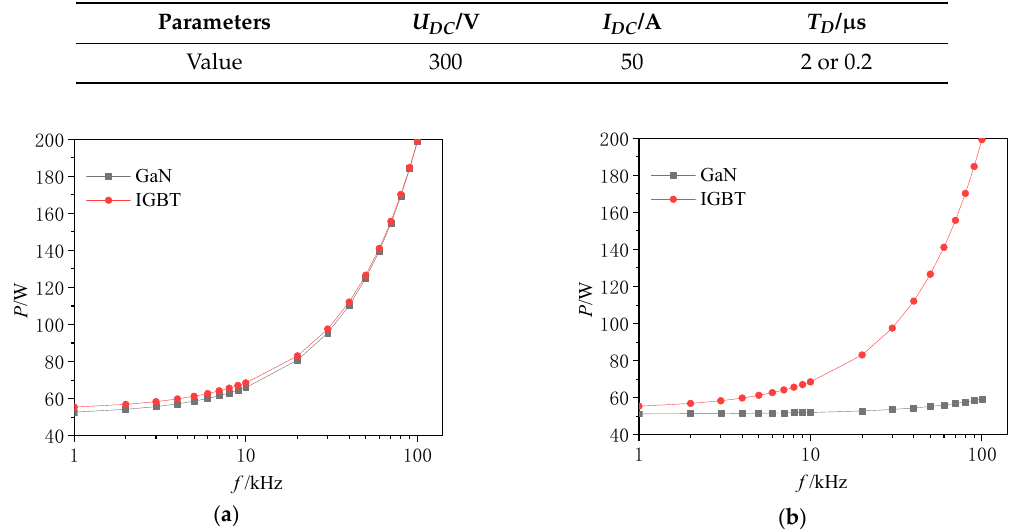
Figure 14. The relationship between GaN reverse loss and frequency with comparison of IGBT using 2 µs dead time. ( a ) GaN with − 3 V turn-off gate voltage and 2 µs dead time. ( b ) GaN with 0 V turn-off gate voltage and 200 ns dead time.